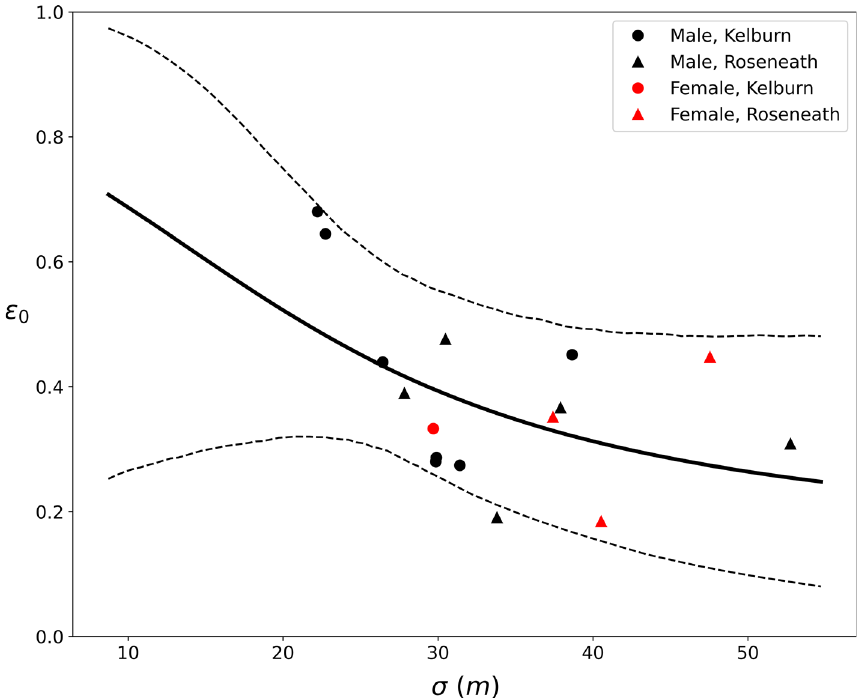
Figure 2. The predicted ε 0 (the nightly probability of an encounter with a device located at the home range center) for 16 individual ship rats, Rattus rattus , as a function of the estimated σ (a spatial decay parameter that scales probability of detection to home range size). The solid line indicates the modelled mean, averaged across the three device types and individuals. The dashed lines indicate the 90% credible